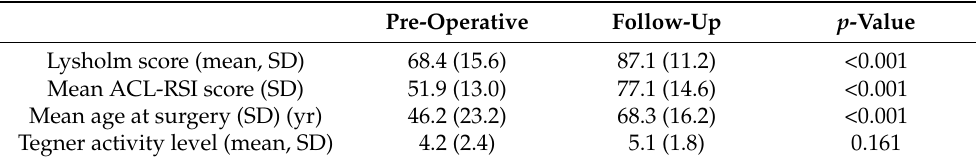
Table 2. Overall comparison between pre-operative and follow-up status.